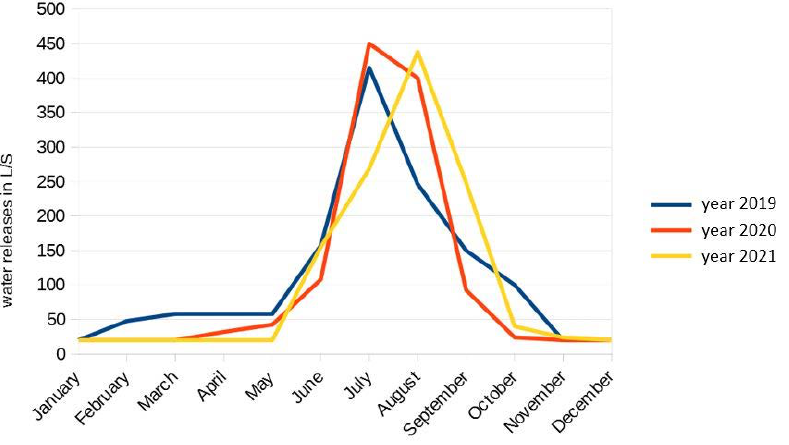
Figure 1. Map of the Mond é ly reservoir showing the location of the study site (red rectangle). The dam is visible at the upper side of the reservoir.